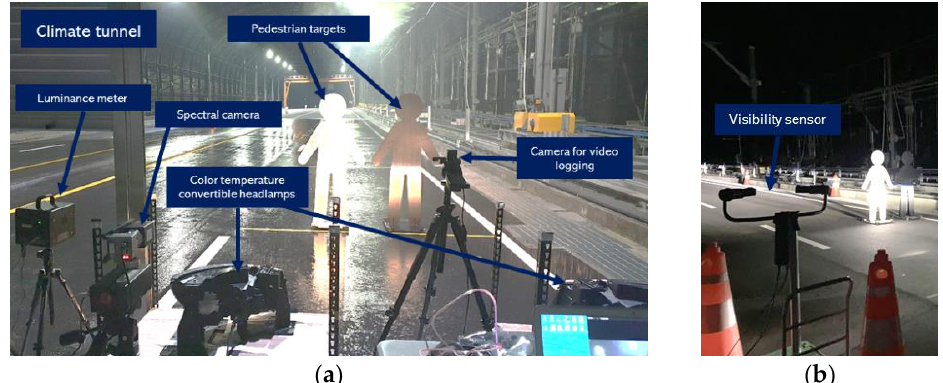
Figure 7. Implementation of fog and rain conditions in the test facility: ( a ) Inside view of the climatic tunnel; ( b ) fog generator operation inside the tunnel; ( c ) rainfall by rain nozzles inside the tunnel.